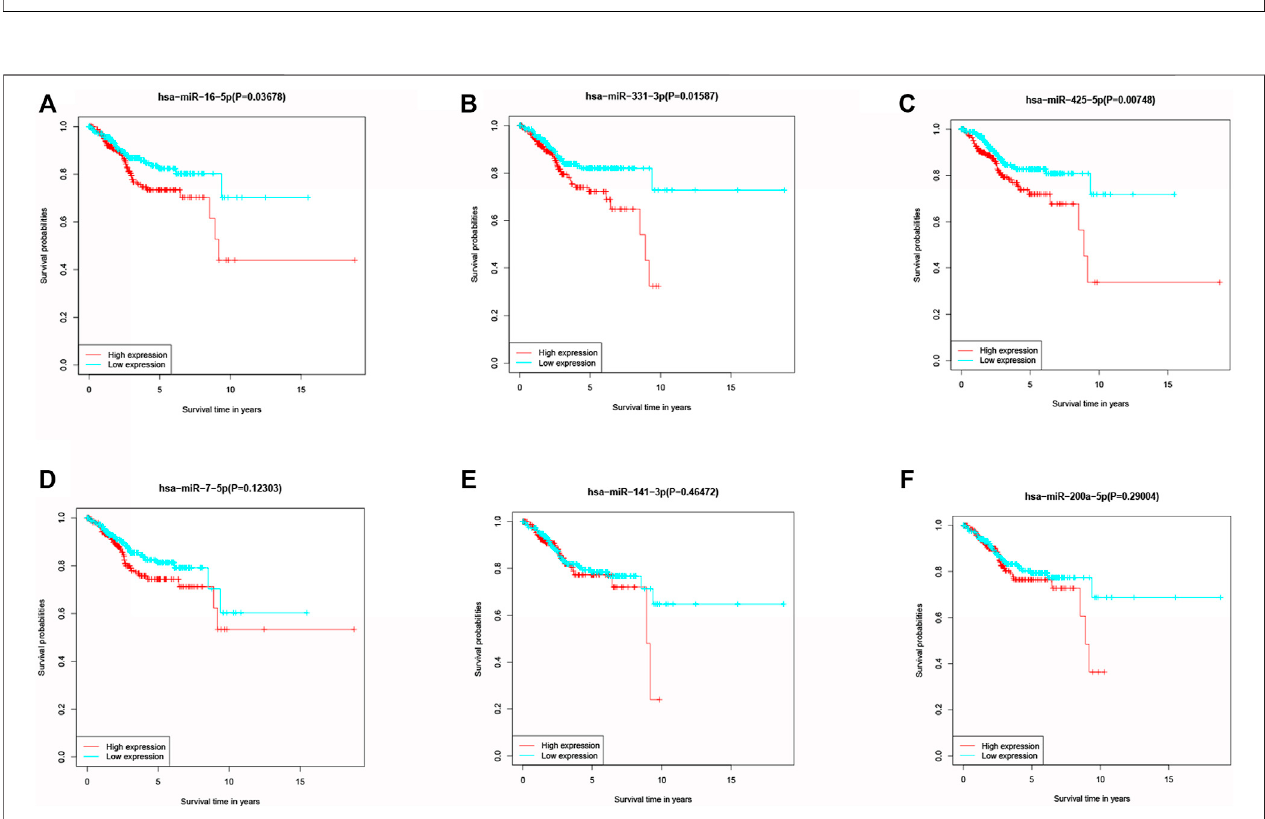
FIGURE2| Kaplan – Meier curves oftheOSfor sixmiRNAs. (A) Kaplan – Meier curves of theOSfor miR-16-5p. (B) Kaplan – Meier curves ofthe OSfor miR-331-3p. (C) Kaplan – Meier curves of the OS for miR-425-5p. (D) Kaplan – Meier curves of the OS for miR-7-5p. (E) Kaplan – Meier curves of the OS for miR-141-3p. (F) Kaplan – Meier curves of the OS for